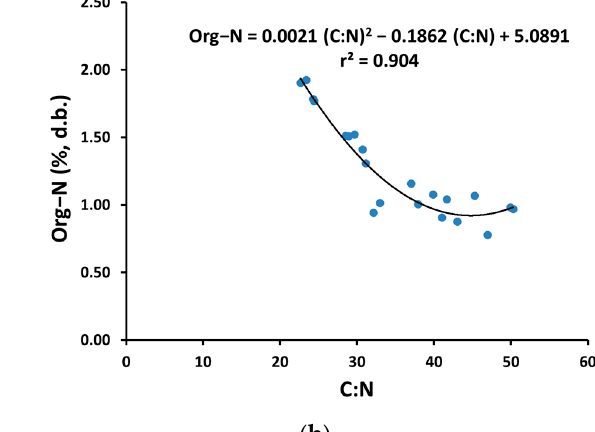
Figure 2. Variation in total phosphorous (P 2 O 5 ) content with respect to C:N. 3.3. Correlation of Electrical Conductivity with Respect to Metal Contents Electrical conductivity is often used as a general measure of soil amendment quality. In some cases, values of EC greater than 3.0 mmhos/cm indicated the presence of salts such as sodium chloride and may reduce seed germination or hinder plant growth [14]. However, a high EC can also be related to the presence of valuable plant nutrients or me- tallic minor nutrients that are electrically conductive. The mean values of EC obtained in this study ranged from 1.54 for manure collected from stalls bedded with generous amounts of wood shavings (Farm 1) to 3.46 for manure collected from stalls bedded with wood pellets (Farm 6). A correlation analysis was performed to determine which metallic elements in the horse manure were associated with increased EC values. The results of the correlation analysis are provided in Table 6. All the metals included could potentially exist in chloride salt form; however, many of these elements could also be complexed with sul- fur. While Na would be expected to be present in the manure as NaCl, the values of EC were not significantly correlated to Na. Furthermore, the only plant nutrient that was sig- nificantly correlated with EC was K 2 O. Therefore, the high EC values observed were di- rectly correlated to high levels of natural potash fertilizer (K 2 O). The variation in EC with respect to the K 2 O contents for all 21 samples is provided in Figure 3 and the coefficient of determination was 0.612. These results demonstrate that EC alone cannot be used to